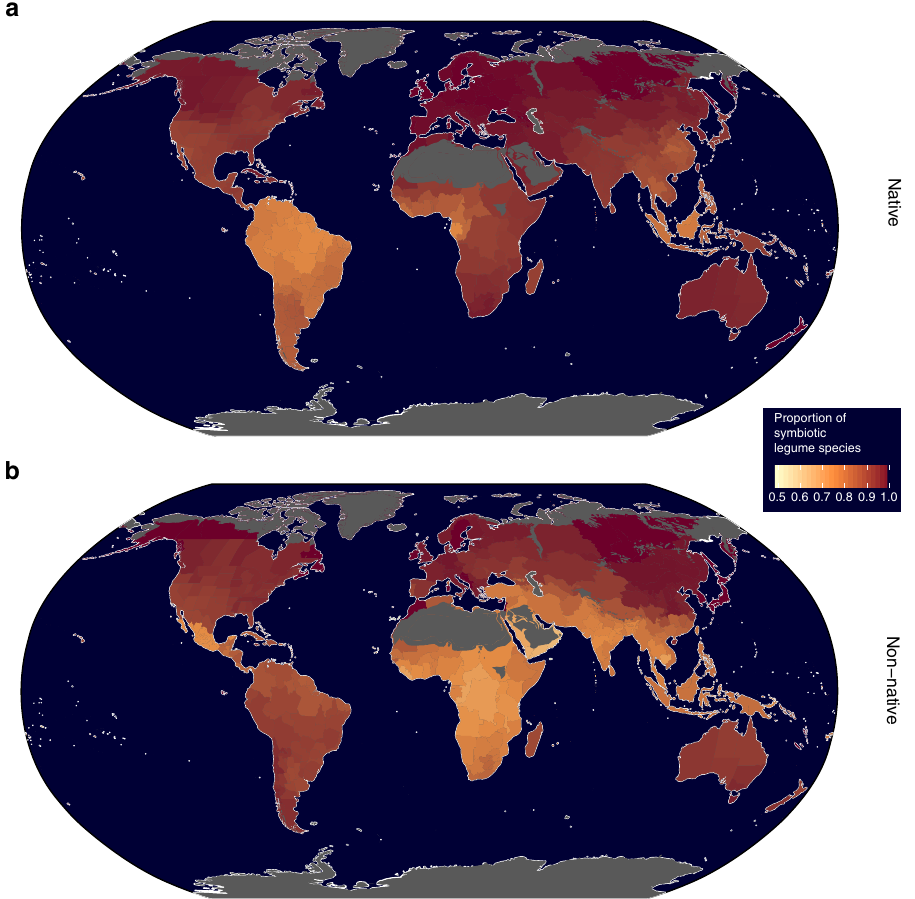
Figure 3 | Global proportional distribution of symbiotic legume species. Regions are coloured according to the proportion of symbiotic legume species in ( a ) native and ( b ) non-native ranges. Lighter colours indicate higher proportions of non-symbiotic legume species. Non-symbiotic legume species tend to primarily occur near the equator in their native range. Non-symbiotic legume species currently account for a higher proportion of species within introduced ranges compared to their proportion within native ranges. The figure shows that the increased spread of non-symbiotic legumes spans multiple continents and islands across the world. Grey areas indicate terrestrial ecoregions where legumes are not known to occur 43 . Regions are defined using the Taxonomic Distribution Working Group system 39